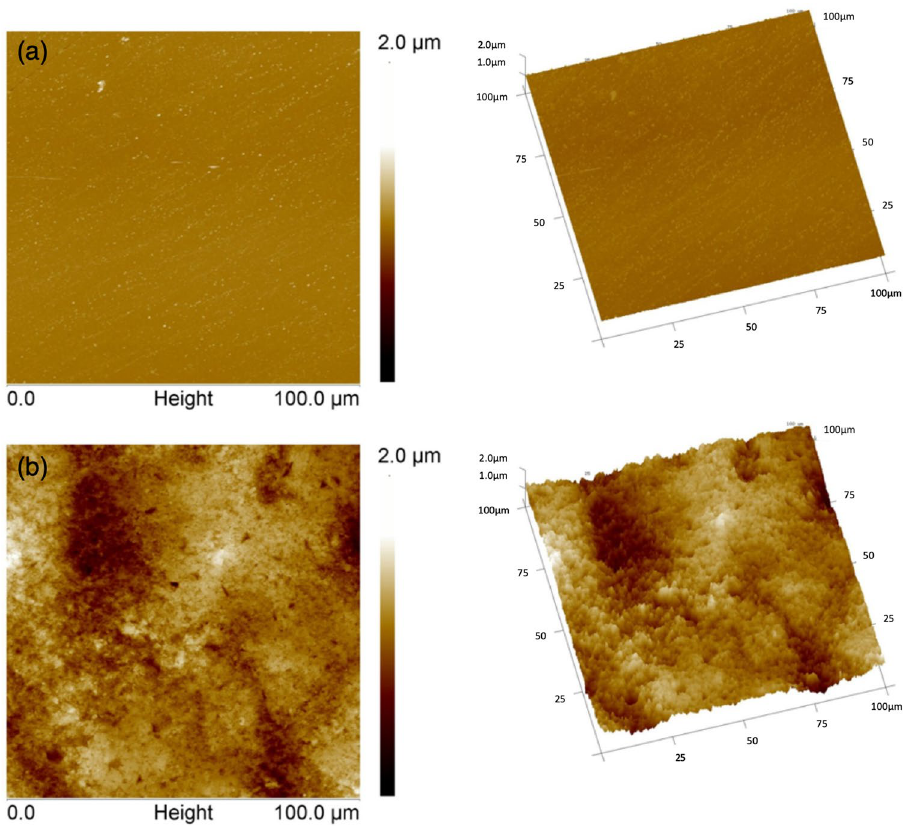
Figure 7. AFM images in contact mode: ( a ) PET and ( b ) SBS. Height images of 100 µm × 100 µm scan area. 2D (left) and 3D (right) views. Z-scale for the height images is 2.0 µm. Tilt = 30° and rotation =